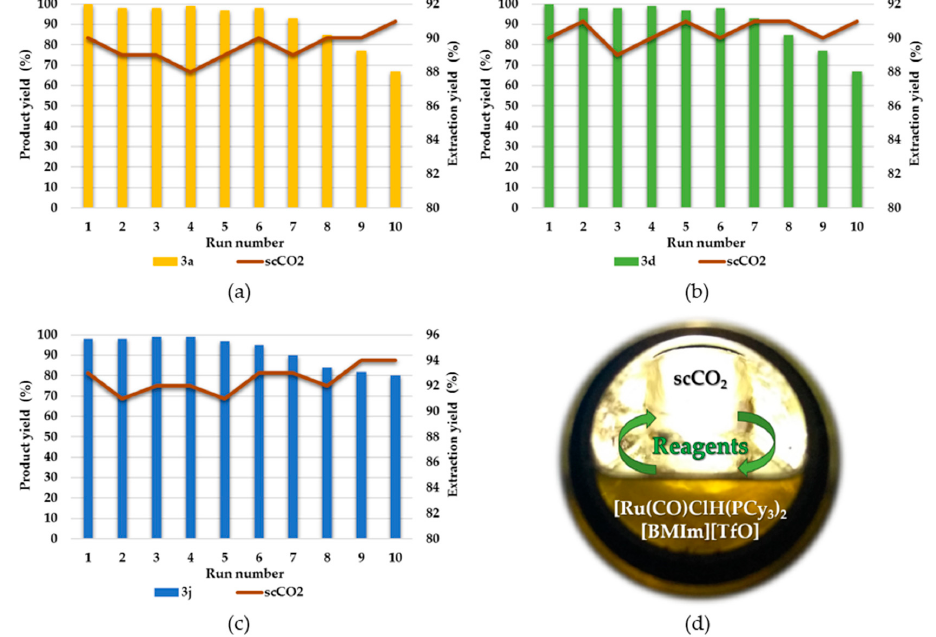
Figure 3. Repetitive batch borylative coupling of 1 with 2a ( a ), 2d ( b ) and 2j ( c ) in [Ru(CO)Cl(H)(PCy 3 ) 2 ]@[BMIm][OTf]/scCO 2 biphasic solvent systems under optimized reaction ([Ru-